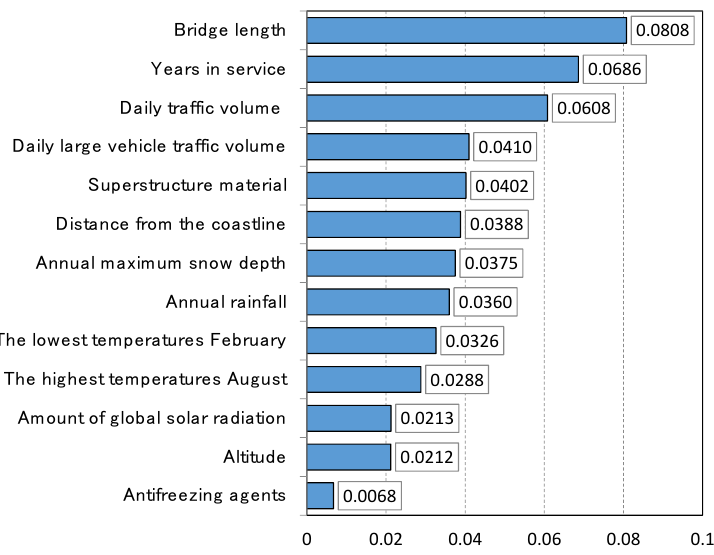
Figure 12. Range of each factor (bearings).